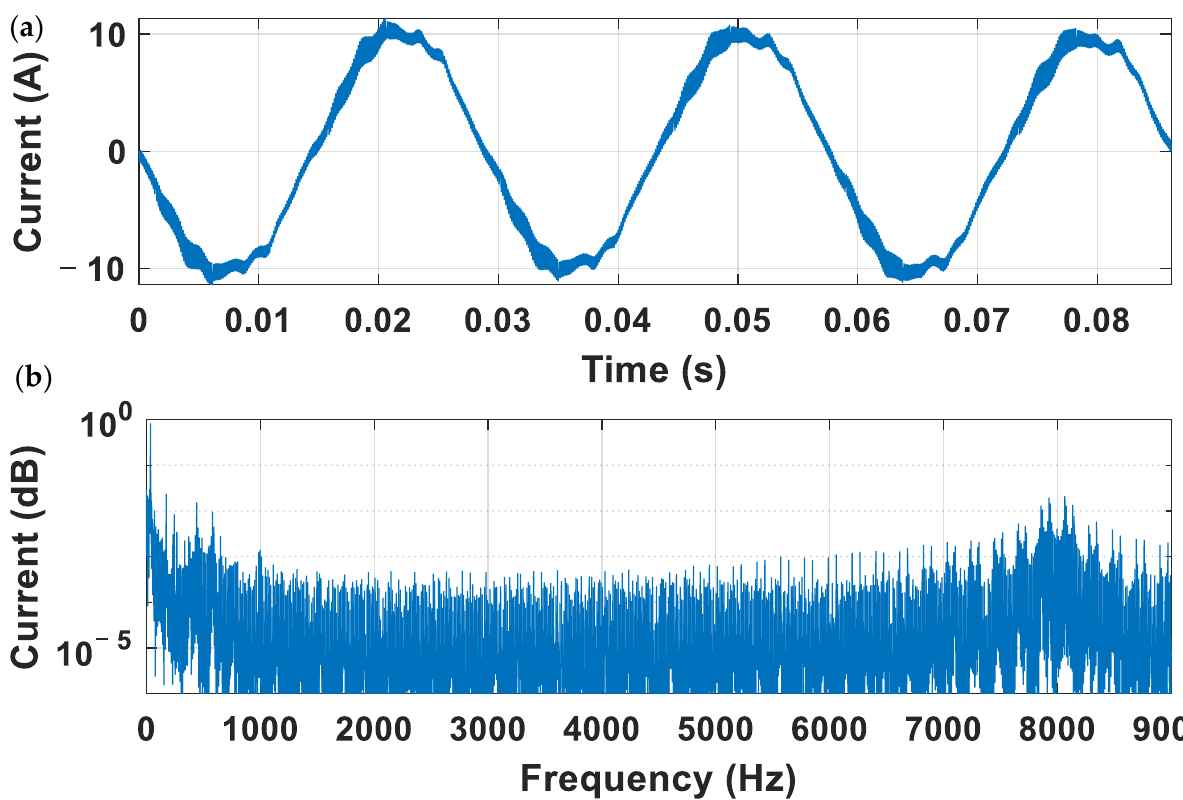
Figure 10. Decomposed signal below 9 kHz. ( a ) Time-domain signal, ( b ) Fourier transform of the signal.